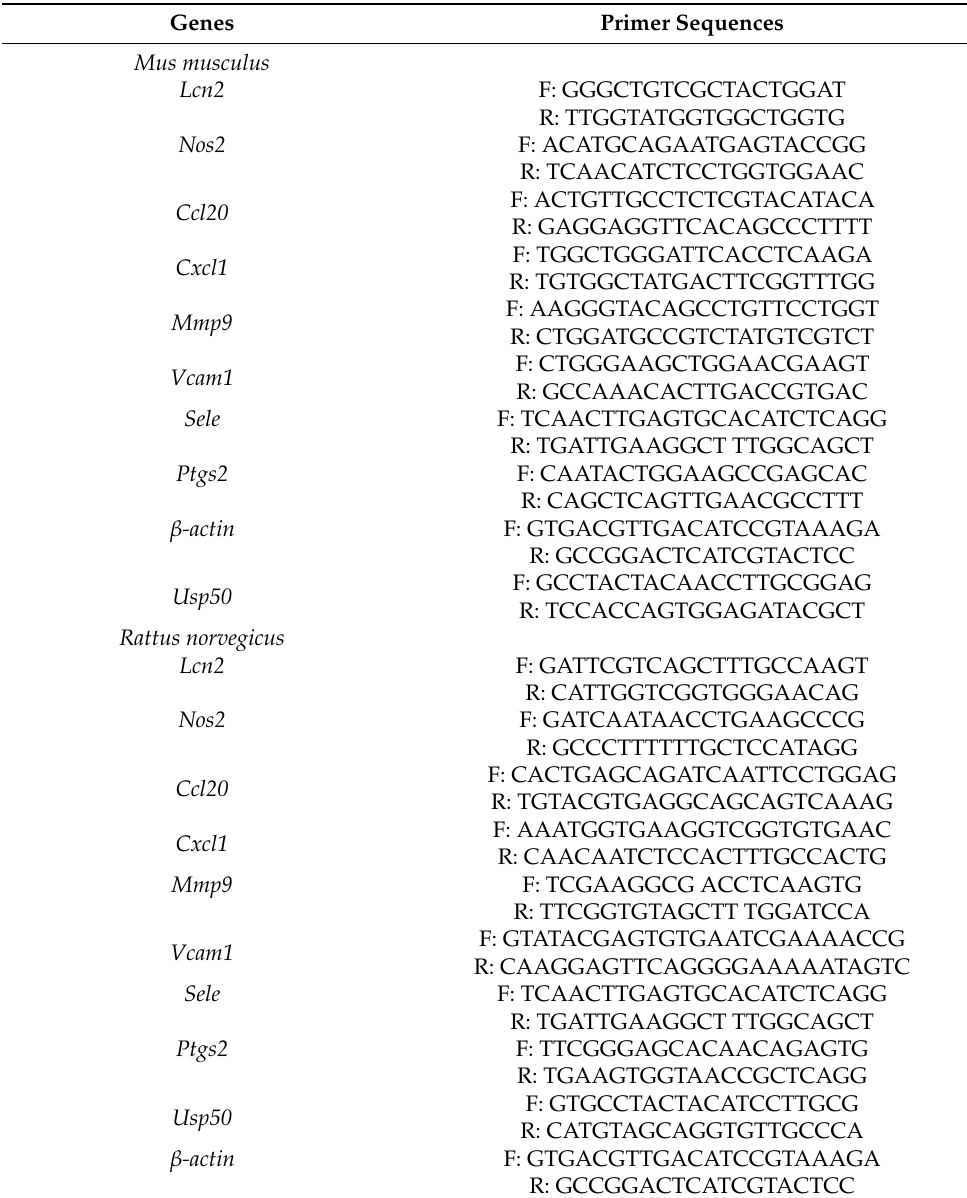
Table 1. Primer information of qPCR